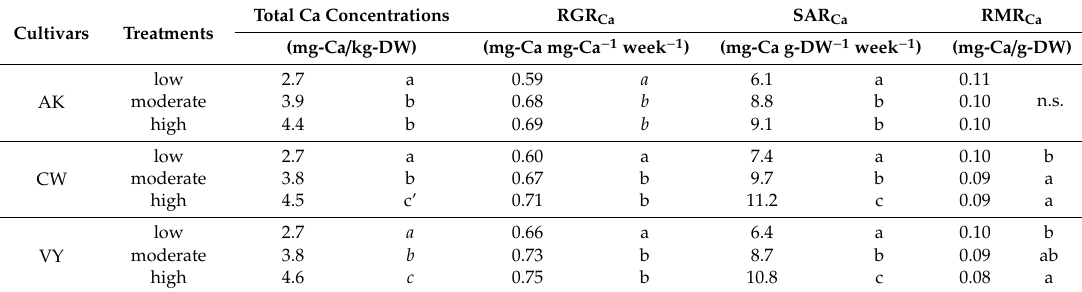
Table 2. Total Ca concentrations, Ca acquisition competence (RGR Ca ), specific Ca absorption rate per unit root mass (SAR Ca ), and root mass ratio per whole-plant Ca content (RMR Ca ) for each cultivar and treatment at the end of the